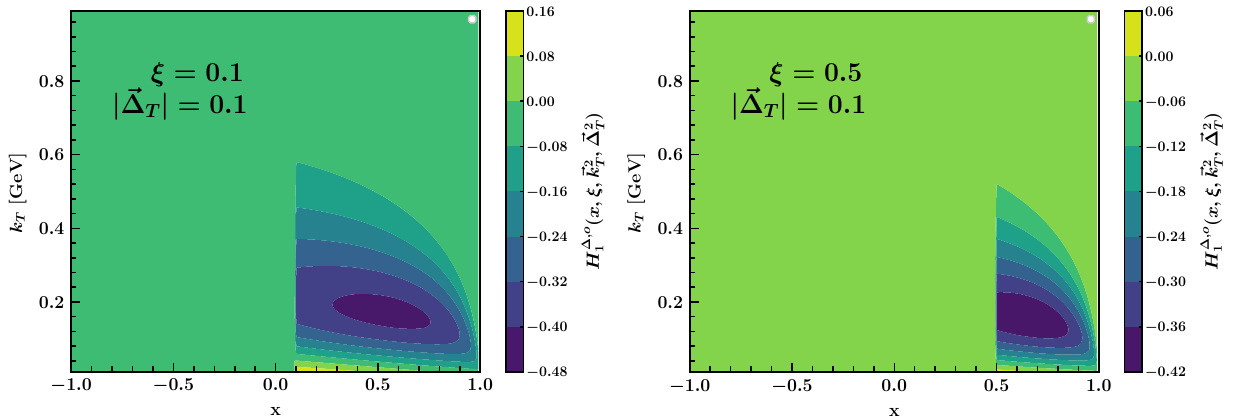
( x ,ξ, (cid:2) k 2 , (cid:2) (cid:3) 2 ) as functions of x and |(cid:2) k T T 1